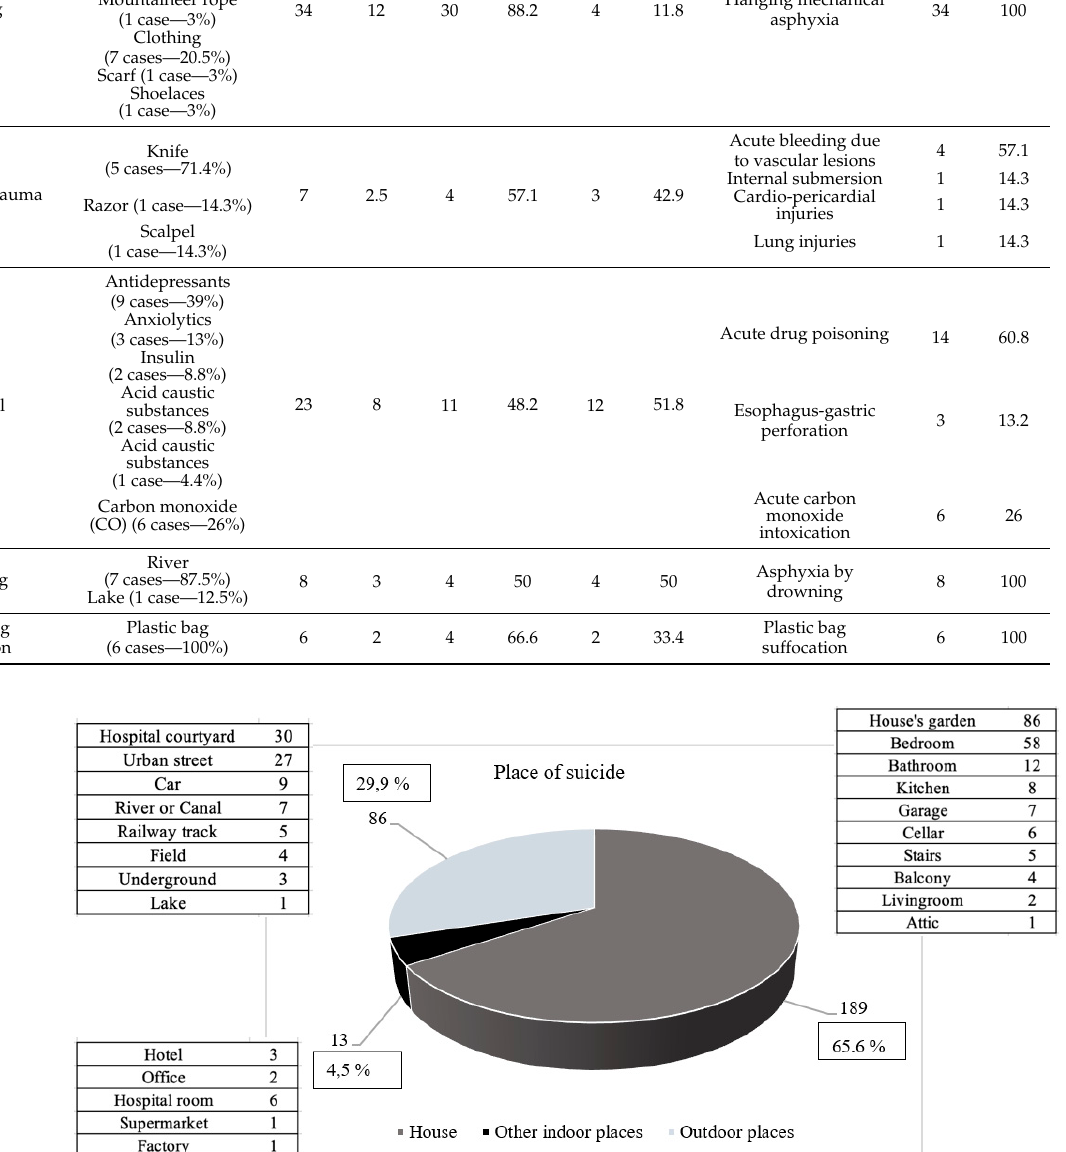
Figure 2. Graphic representation of locations where suicides